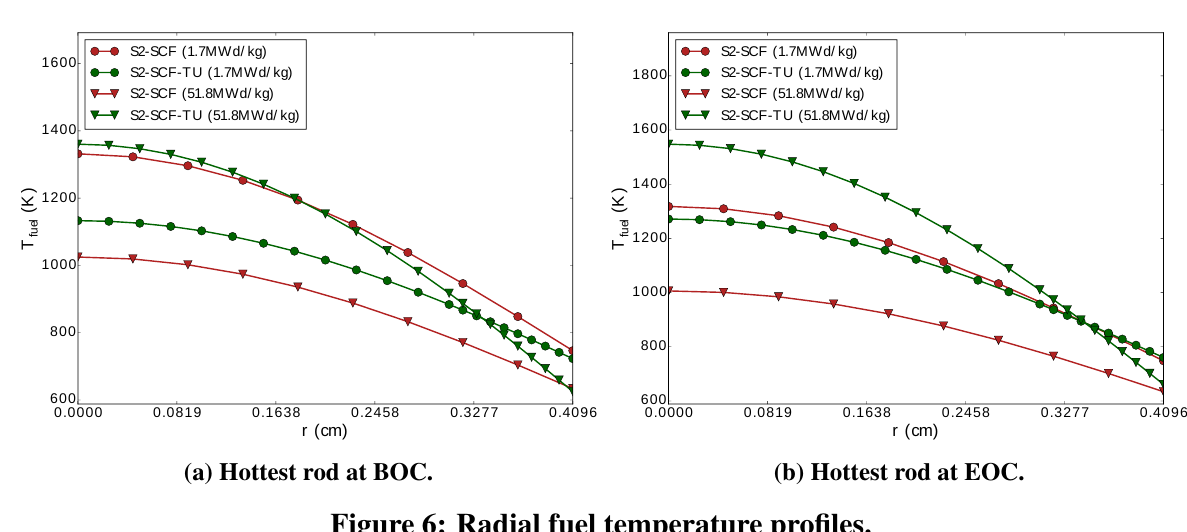
Figure 6: Radial fuel temperature profiles.